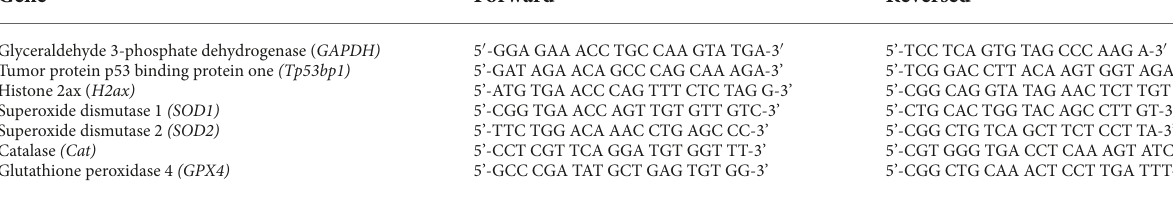
TABLE 1 Primer sequences used for quantitative real-time PCR. Gene Forward Reversed Glyceraldehyde 3-phosphate dehydrogenase (